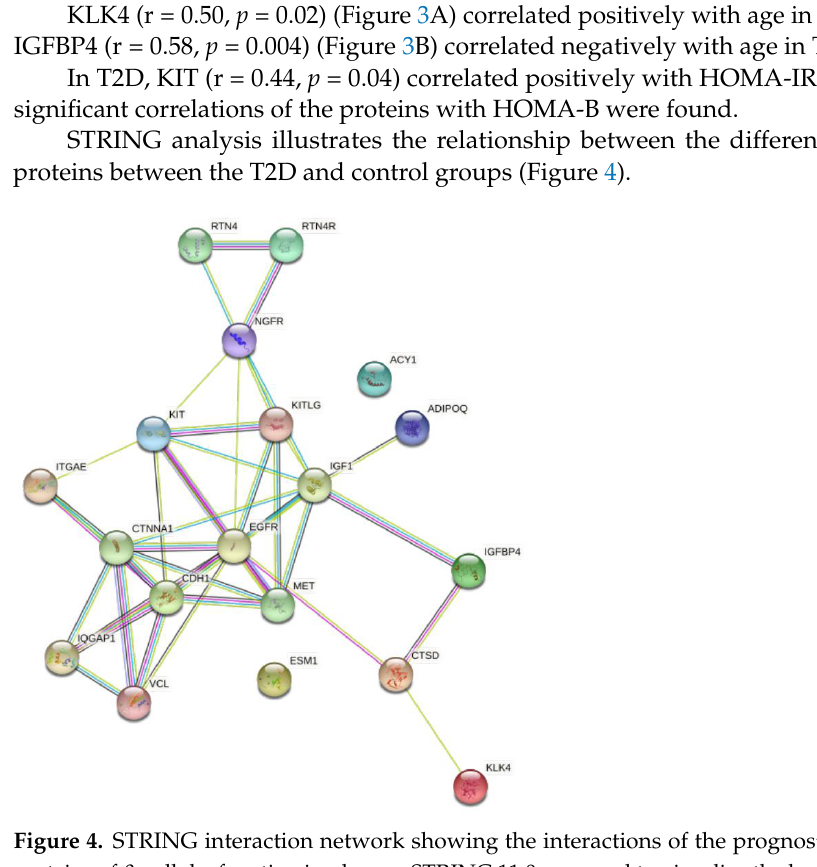
Figure 4. STRING interaction network showing the interactions of the prognostic and diagnostic proteins of β -cell dysfunction in plasma. STRING 11.0 was used to visualize the known and pre- dicted protein-protein interactions for proteins identified by SOMAscan assay in plasma of T2D vs. control subjects (https://string-db. org/) (accessed on 2 December